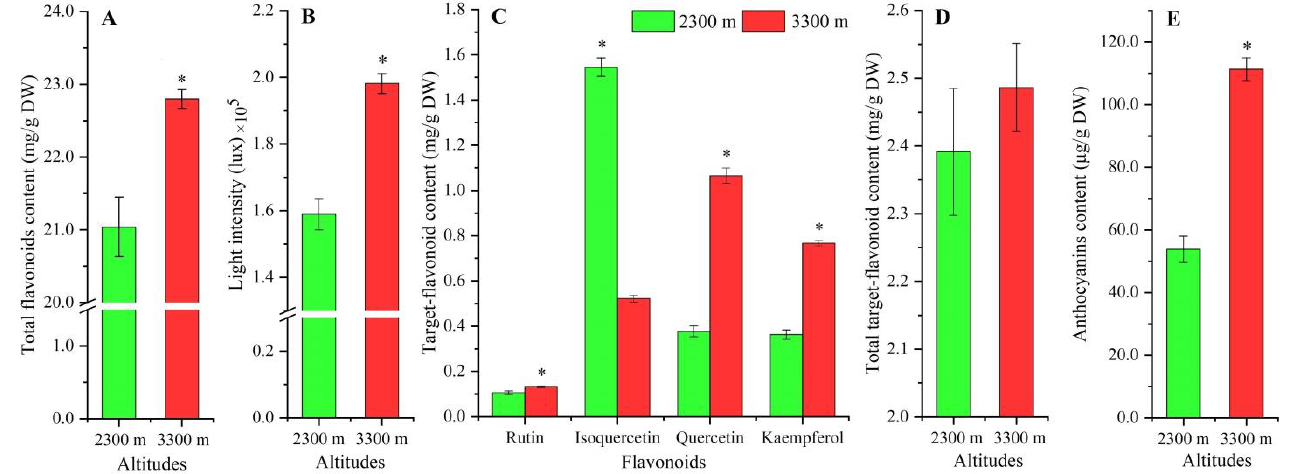
Figure 1. The content of total flavonoids ( A ), light intensity ( B ), content of target flavonoid ( C ), to- tal target flavonoid ( D ), and anthocyanins ( E ) at 2300 and 3300 m. The * represents a significant difference ( p < 0.05) between 2300 and 3300 m (mean ± SD, n = 3).